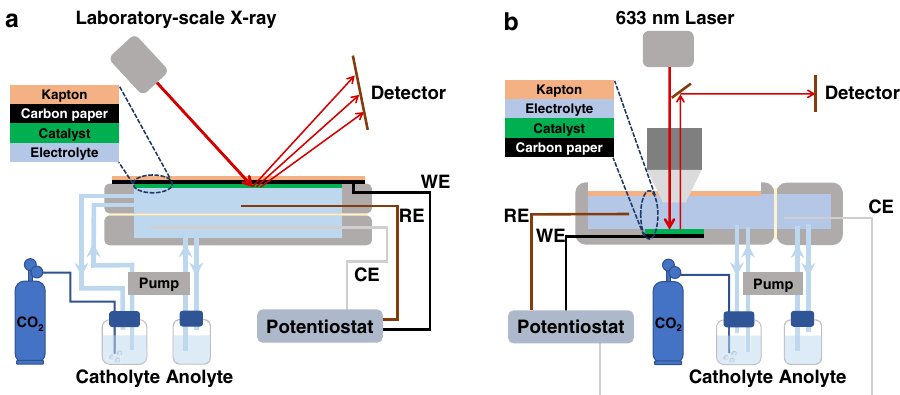
Fig. 1 | Schematicillustrationofthe operando characterizationplatforms.a X-ray diffraction(XRD) and b Ramanspectroscopy for CO 2 reduction reactions (CO 2 RRs) with the three investigated oxidized Cu